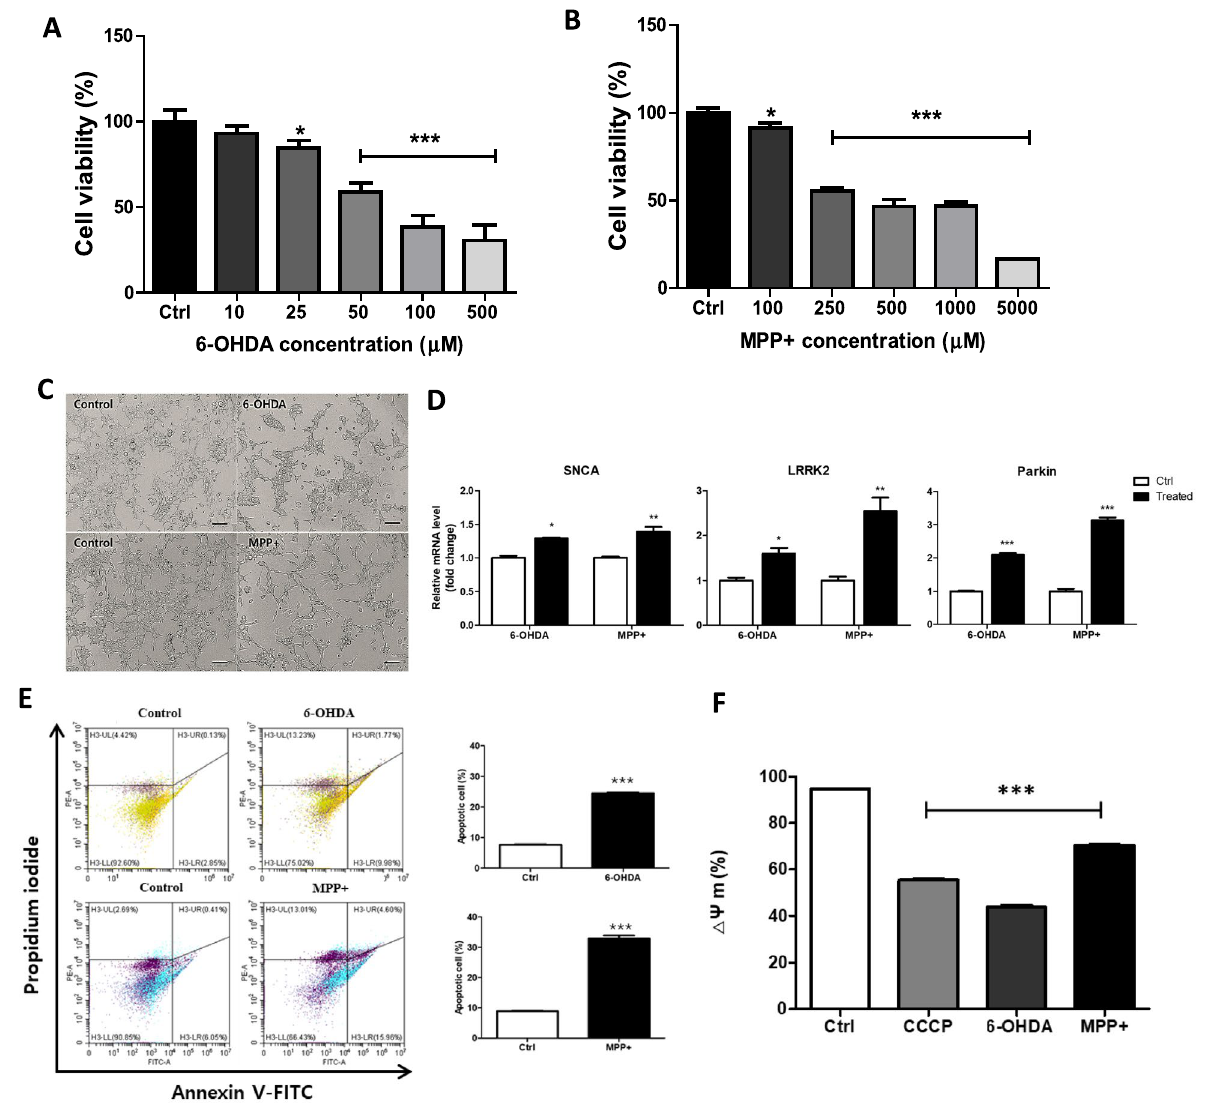
Fig. 1 In vitro model validation of Parkinson’s disease for SH‑SY5Y cells treated with 6‑OHDA or MPP . SH‑SY5Y cells were treated with different + concentrations of A 6‑OHDA (0, 10, 25, 50, 100, and 500 μ Μ ) or B MPP (0, 100, 250, 500, 1000, and 5000 μ Μ ) for 48 h; cell viability was analyzed + using Cell Counting Kit‑8. C Cellular morphology changes caused by 50 µM 6‑OHDA and 500 µM MPP (Scale bar 100 μm). D The expression + = of PD‑related genes, including SNCA , LRRK2 , and parkin, was confirmed in 6‑OHDA or MPP ‑treated SH‑SY5Y cells using qRT‑PCR. The β‑actin + transcript served as an internal control. Apoptosis was quantified via FACS after Annexin V‑FITC and PI labeling. Representative FACS data are shown for SH‑SY5Y cells treated with 6‑OHDA and MPP under normal and low fetal bovine serum (5%) conditions. The abscissa and ordinate + represent the fluorescence intensity of Annexin V‑FITC and PI, respectively. E The bar graph represents the level of apoptosis. F Cells were treated with 6‑OHDA or MPP for 48 h, and the mitochondrial membrane potential (ΔψM) was measured based on JC‑1 fluorescence via flow + cytometry. (*** p < 0.001, ** p < 0.01, * p < 0.05, n 3). 6-OHDA 6‑hydroxydopamine, MPP 1‑methyl‑4‑phenylpyridinium; Ctrl control, FITC fluorescein = + isothiocyanate, PI propidium